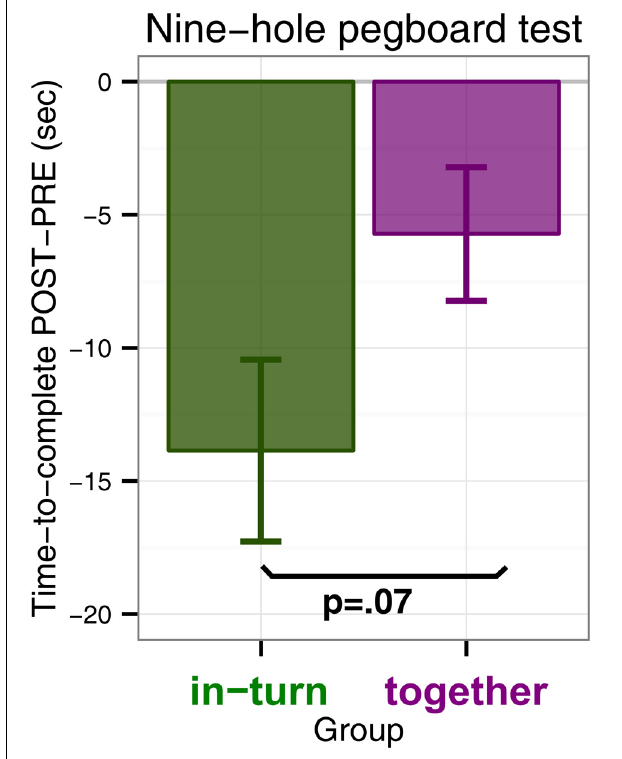
FIGURE 1 | Nine-hole pegboard test scores measured as the difference in time-to-complete POST minus time-to-complete at PRE (in seconds). A negative difference indicates that patients completed the Nine-hole pegboard test faster after therapy (POST) than before (PRE).